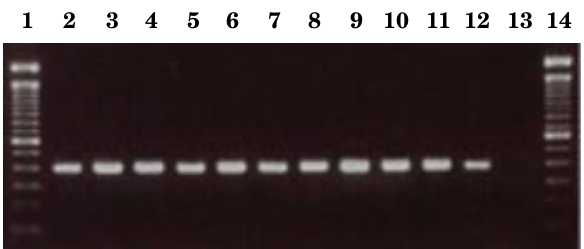
Fig. 1. Amplicons of direct polymerase chain reaction using the primer-pair Dest1 and Dest4 and DNA from different Cylindrocarpon destructans cultures. Lanes: